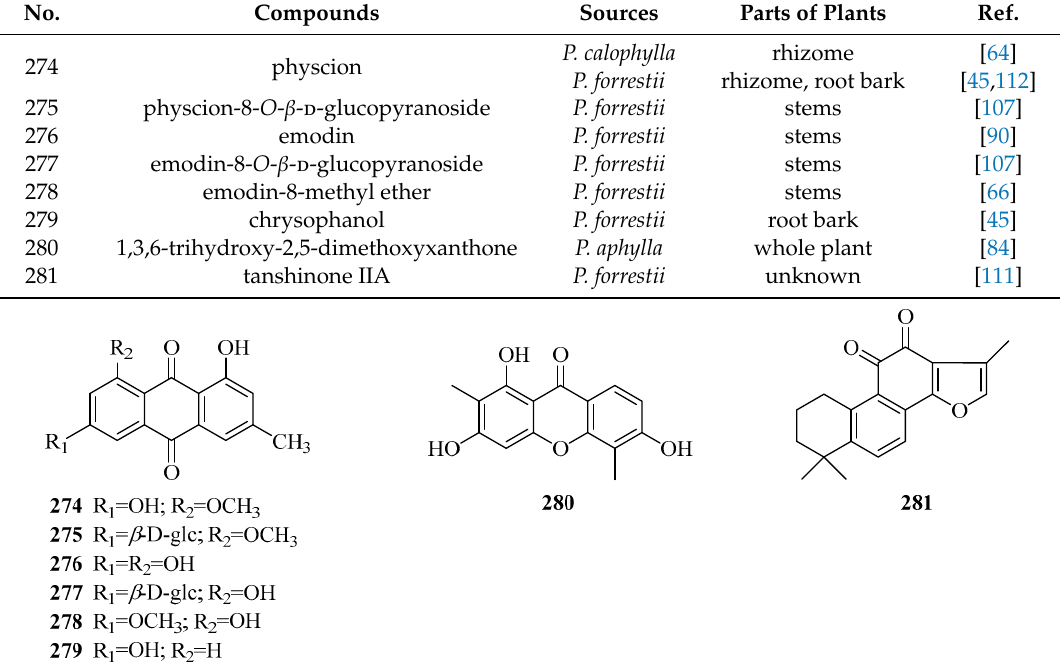
Table 7. Quinones from the genus Periploca .